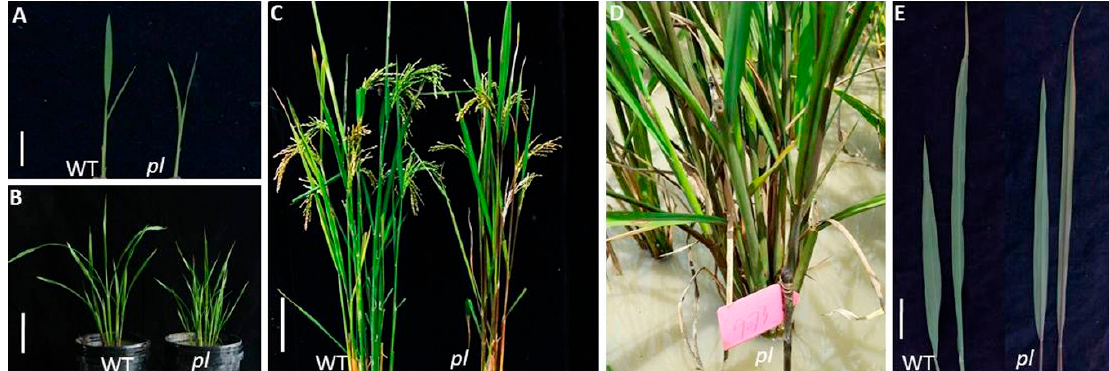
Figure 1. Phenotypic features of WT and pl mutant rice plants. Plants at ( A ) seedling stage, bar: 2 cm; ( B ) tillering stage, bar: 10 cm; ( C ) grain filling stage, bar: 10 cm; ( D ) pl plants showing purple color at field condition; ( E ) magnification of flag leaf from the top of the plant, bar = 5 cm.